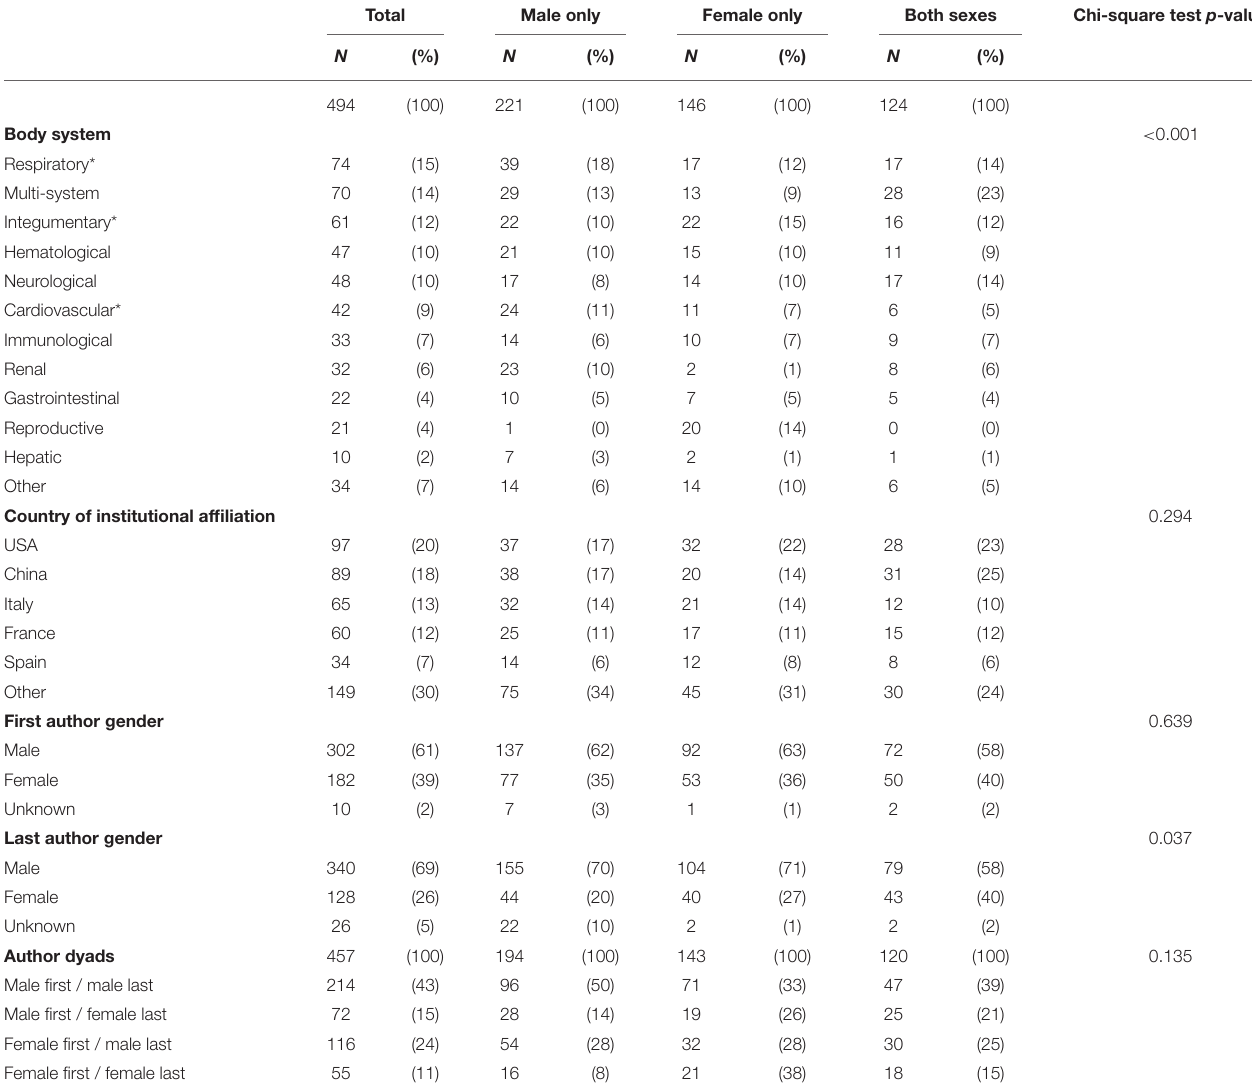
TABLE 1 | Case study characteristics and article